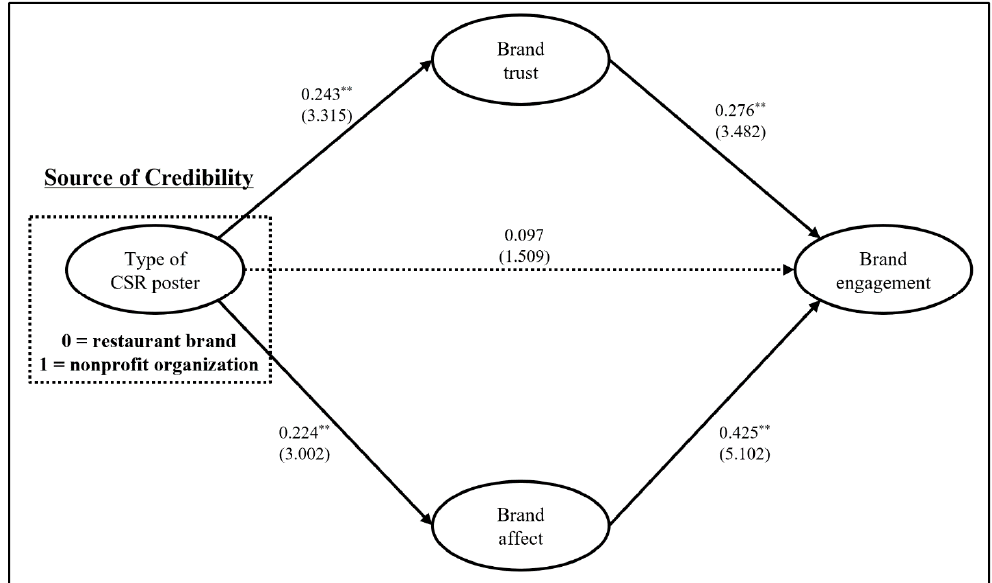
Figure 1. Results of structural equation modeling. Note. Standardized estimate (critical ratio), solid line: significant path, dotted line: insignificant path. ** p < 0.01.